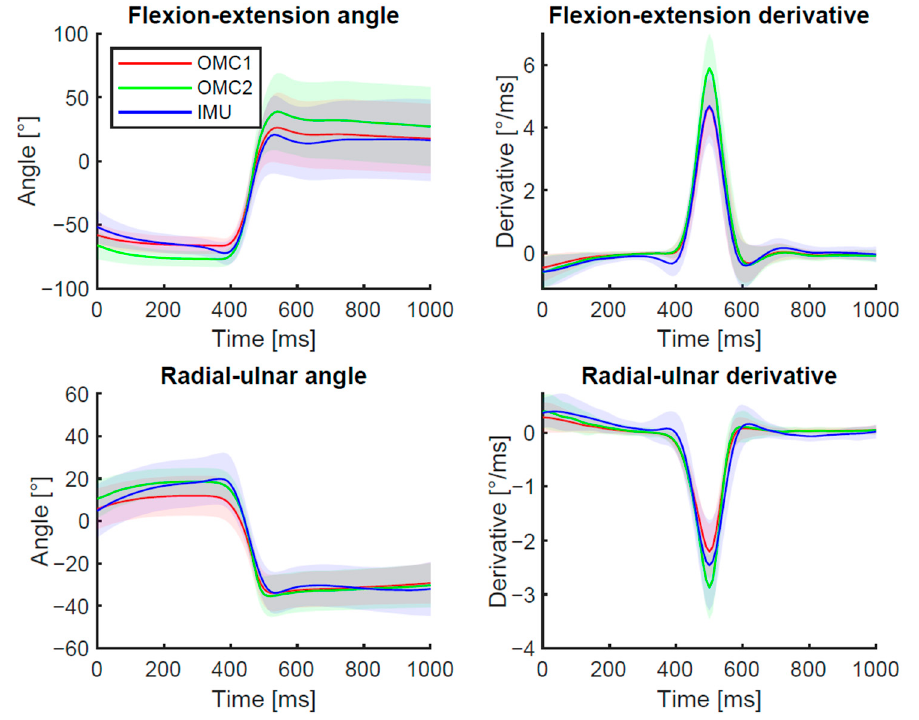
Figure 4. Mean ( ± SD) angles and derivatives over all trials and subjects for each measurement method. The signals are aligned using a rigid translation and cropped to 500 ms before and after the maximum derivative of the flexion angle. The derivative is filtered using a Gaussian filter.